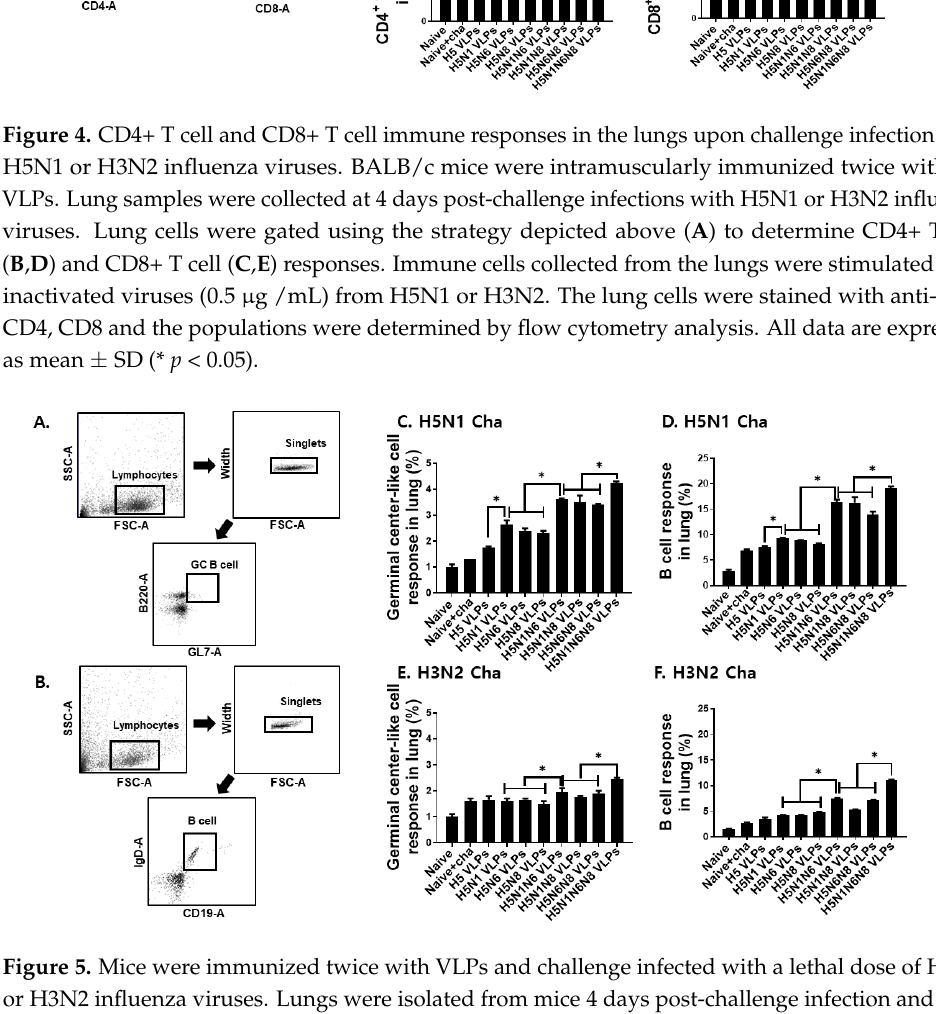
Figure 4. CD4+ T cell and CD8+ T cell immune responses in the lungs upon challenge infection with H5N1 or H3N2 influenza viruses. BALB/c mice were intramuscularly immunized twice with the VLPs. Lung samples were collected at 4 days post-challenge infections with H5N1 or H3N2 influ- enza viruses. Lung cells were gated using the strategy depicted above ( A ) to determine CD4+ T cell ( B , D ) and CD8+ T cell ( C , E ) responses. Immune cells collected from the lungs were stimulated with inactivated viruses (0.5 μ g /mL) from H5N1 or H3N2. The lung cells were stained with anti-CD3, CD4, CD8 and the populations were determined by flow cytometry analysis. All data are expressed as mean ± SD (* p < 0.05).